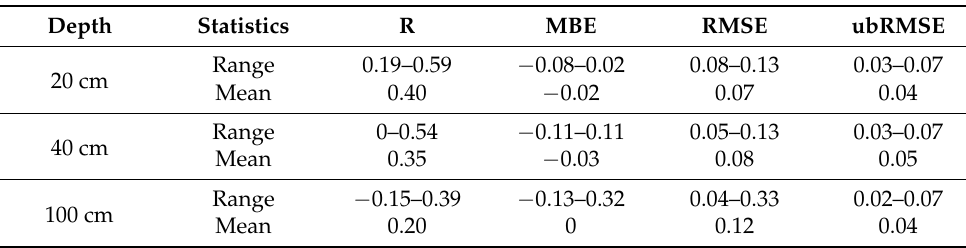
Figure 11. The evaluation metrics of R ( a ), MBE ( b ), RMSE ( c ) and ubRMSE ( d ) at the depths of 20, 40, 100 cm between SWI o normalized by in situ soil moisture and SWI m estimated by RF_SMAP_P_L3 surface soil moisture. “+” represent outliers of T opt . Table 3. Summary of metrics (R, MBE, RMSE and ubRMSE) between estimated SWI m and observed SWI o at depths of 20, 40 and 100